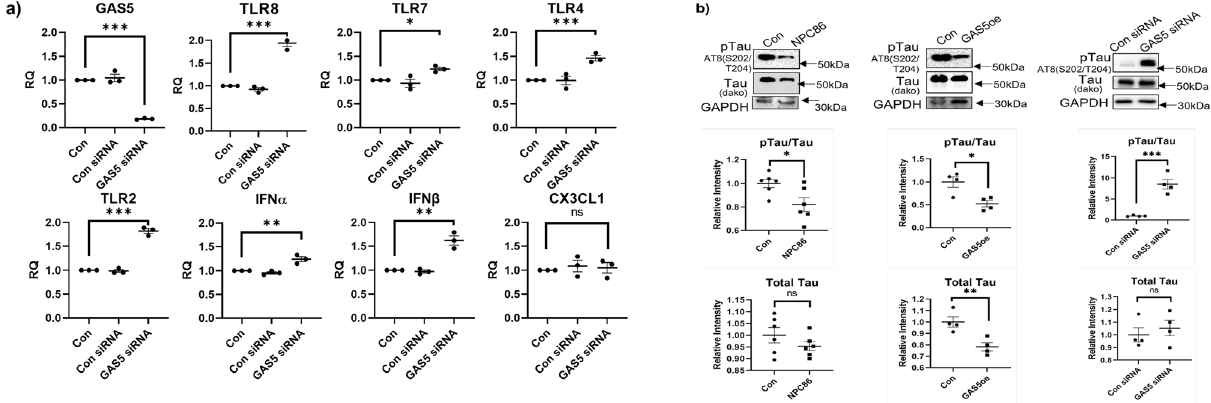
Figure 7. GAS5 regulates TLR8 expression and tau phosphorylation. ( a ) HT22 cells were transfected with GAS5 siRNA or scrambled control siRNA (Con siRNA) for 48 h. RNA was isolated, qPCR was performed, normalized to β-actin expression and relative quantification (RQ) was determined for GAS5, TLR8, TLR 7, TLR 4, TLR 2, IFNα, IFNβ, and CX3CL1 levels, with control set as reference (n = 3). Statistical analysis was performed by one-way ANOVA, *p < 0.05, **p < 0.01, ***p < 0.001. ( b ) HEK293T cells were transiently transfected to overexpress tauP301L. Cells were either treated with 20 nM NPC86 or co-transfected with GAS5 TOPO plasmid or transfected with 25 nM GAS5 siRNA. Western blot analysis was performed using antibodies for pTau and total Tau as indicated (n = 5). Densitometric analysis was performed, pTau and Tau levels